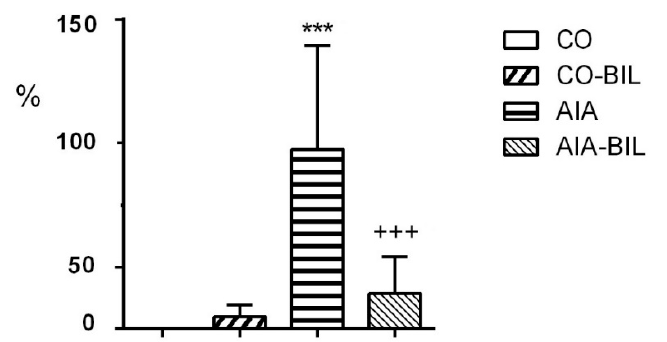
Figure 6. Fibrin exudation into joints. CO—control group, CO-BIL—control group administered with UCB 200 mg/kg of body weight daily i.p. from day 14, AIA—group with adjuvant induced arthritis, AIA-BIL—group with adjuvant induced arthritis administered with UCB 200 mg/kg of body weight daily i.p. from day 14. Results are expressed as mean ± SEM, n = 7–8. Significant difference between groups CO and CO-BIL, CO and AIA: *** p < 0.001 vs. CO. Significant difference between groups AIA and AIA-BIL: +++ p < 0.001 vs. AIA.